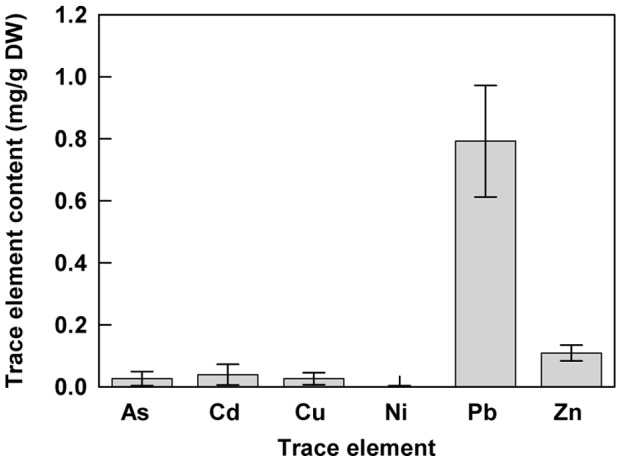
Amount of metallic trace elements (As, Cd, Cu, Ni, Pb and Zn) in shoots of H. incana.
Plants were collected from different zones in a heavy metal-polluted area. Data are the average (± SE) of six independent measurements. Amount (average ± SE) of metallic trace elements in the soil (mg/Kg): As = 298±80; Cd = 10±4; Cu = 459±88; Ni = 13±6, Pb = 7157±746; Zn = 14164±1460.